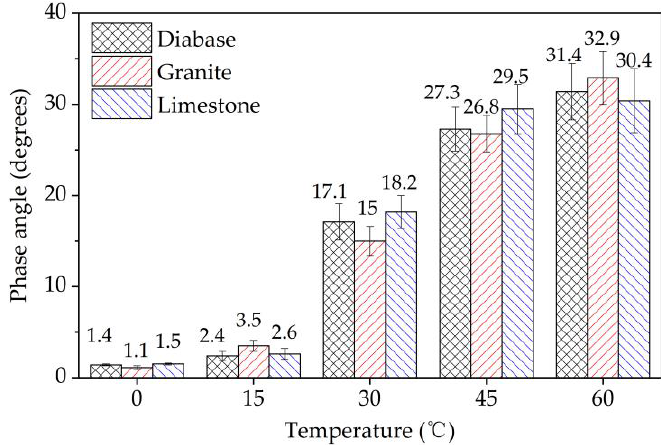
Figure 21. The initial phase angle in the four-point bending tests.